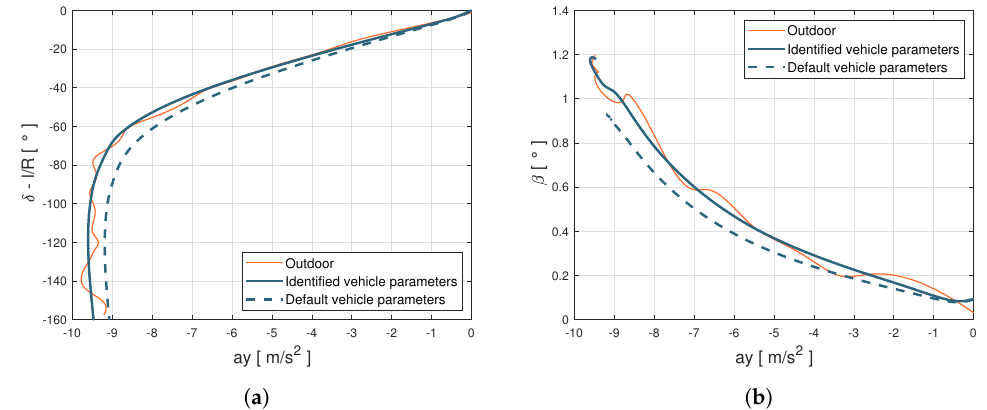
Figure 14. Comparison between outdoor acquisitions and simulation output. ( a ) Steering angle vs. lateral acceleration diagram. ( b ) Sideslip angle vs. lateral acceleration